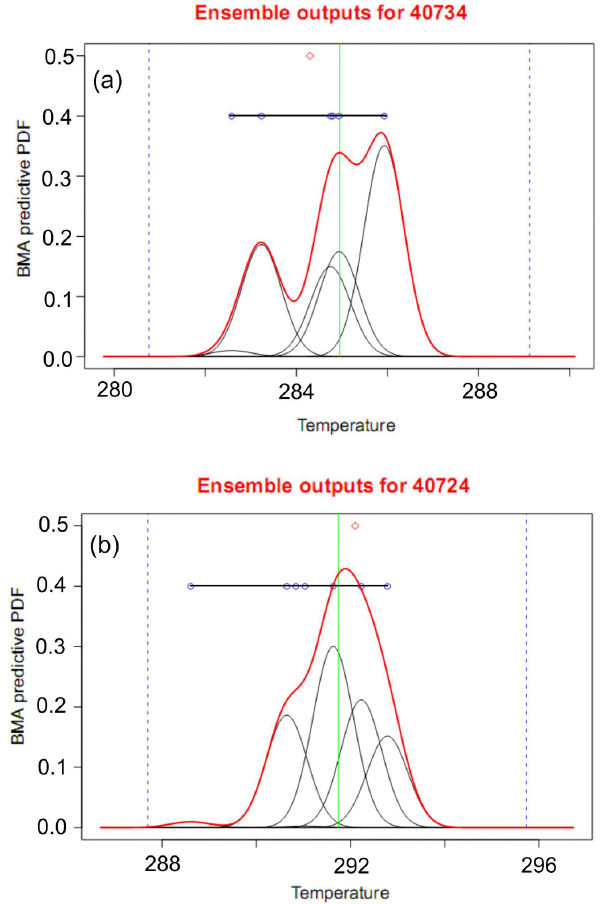
Fig. 7. BMA predictive PDF (thick red curve) and its seven com- ponents (thin black curves) for the 48-h surface temperature for two synoptic stations of (a) Piranshahr and (b) Noshahr in itialized at 12:00UTC on first February and first May 2009, respectively. Also shown are the ensemble member forecasts and range (solid horizon- tal line and blue bullets), observation (red bullets), the BMA 90% prediction interval (dotted lines) and the median of the PDF (solid green vertical